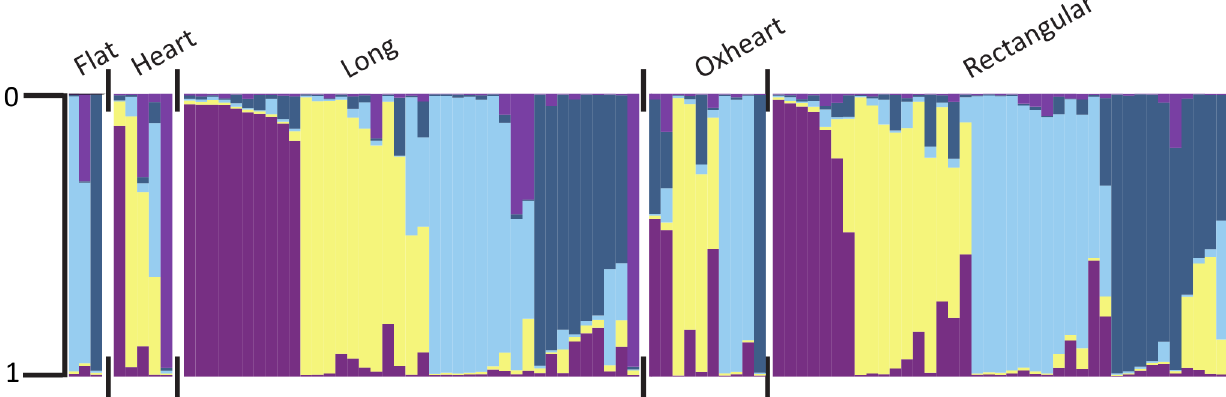
Fig 3. Population structure of pepper ( Capsicum annuum ) grouped by fruit shape categories described by Rodriguez et al [14]. Only categories represented by more than four individuals are included. Individuals are represented by their proportionate membership (0 to 1) in cluster 1 (purple), cluster 2 (light yellow), cluster 3 (sky blue), cluster 4 (steel blue), or cluster 5 (orchid). A white space and black tick marks separate subgroups of individuals.